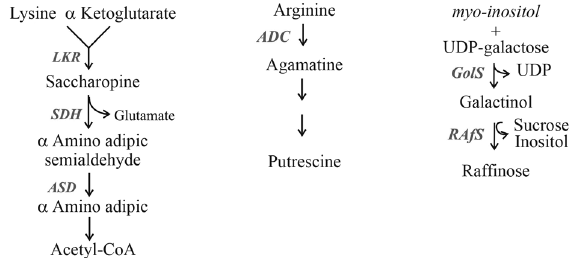
Figure 2 - Schematic diagram of pathways for ( A) Lysine degradation II, (B) Putrescine biosynthesis I, and (C) Stachyose biosynthesis. Enzyme names are in green letters and